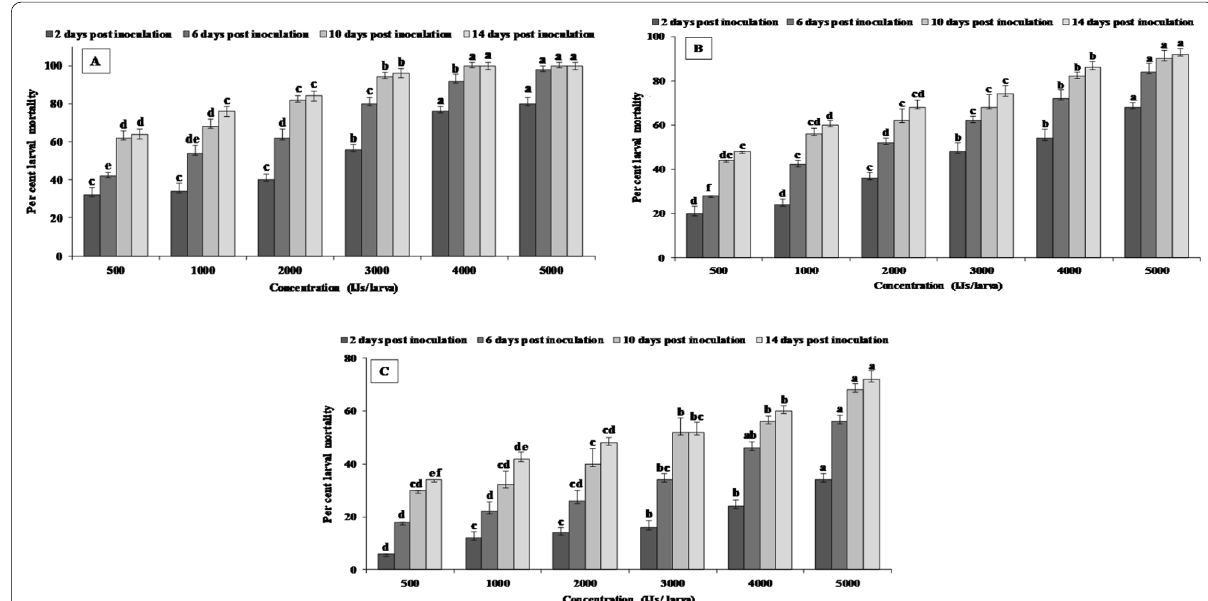
Fig. 1 Per cent mortality of grubs of Oryctes rhinoceros exposed to different concentration of infective juveniles (IJs) of Entomopathogenic nematodes (EPNs): A Steinernema carpocapsae , B Steinernema abbasi , C Heterorhabditis indica . In a bar column with different alphabet letter were significantly different at Tukey’s HSD at P 0.0001 =